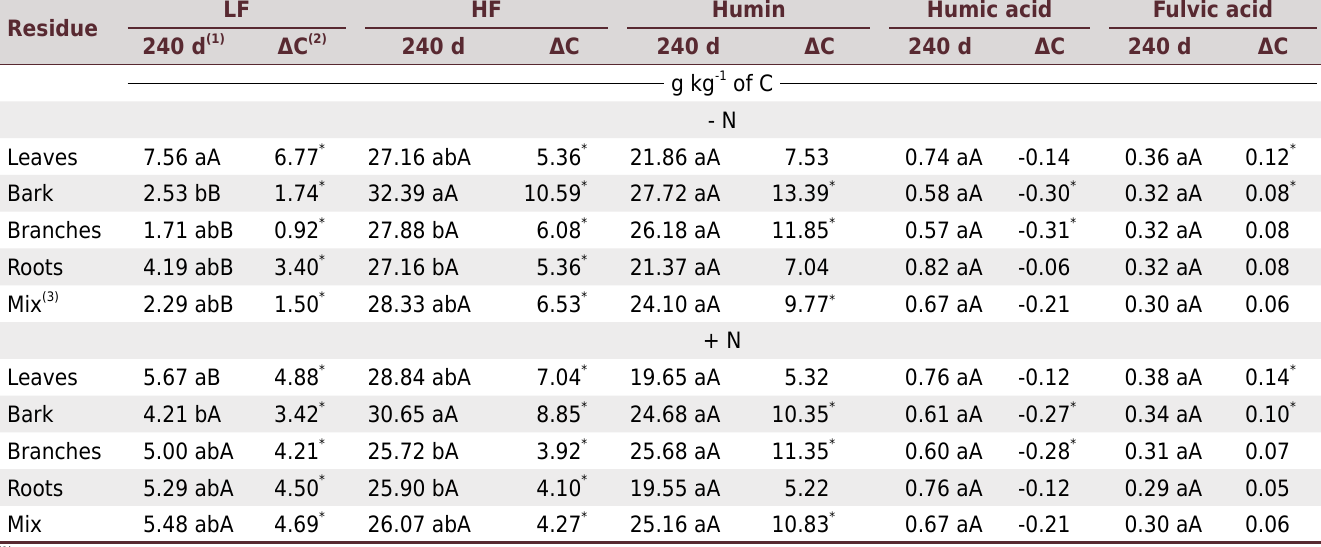
Table 2. Changes in the carbon content of soil organic matter fractions 240 days after application of different residues of Eucalyptus with or without the addition of mineral nitrogen (200 mg kg -1 of